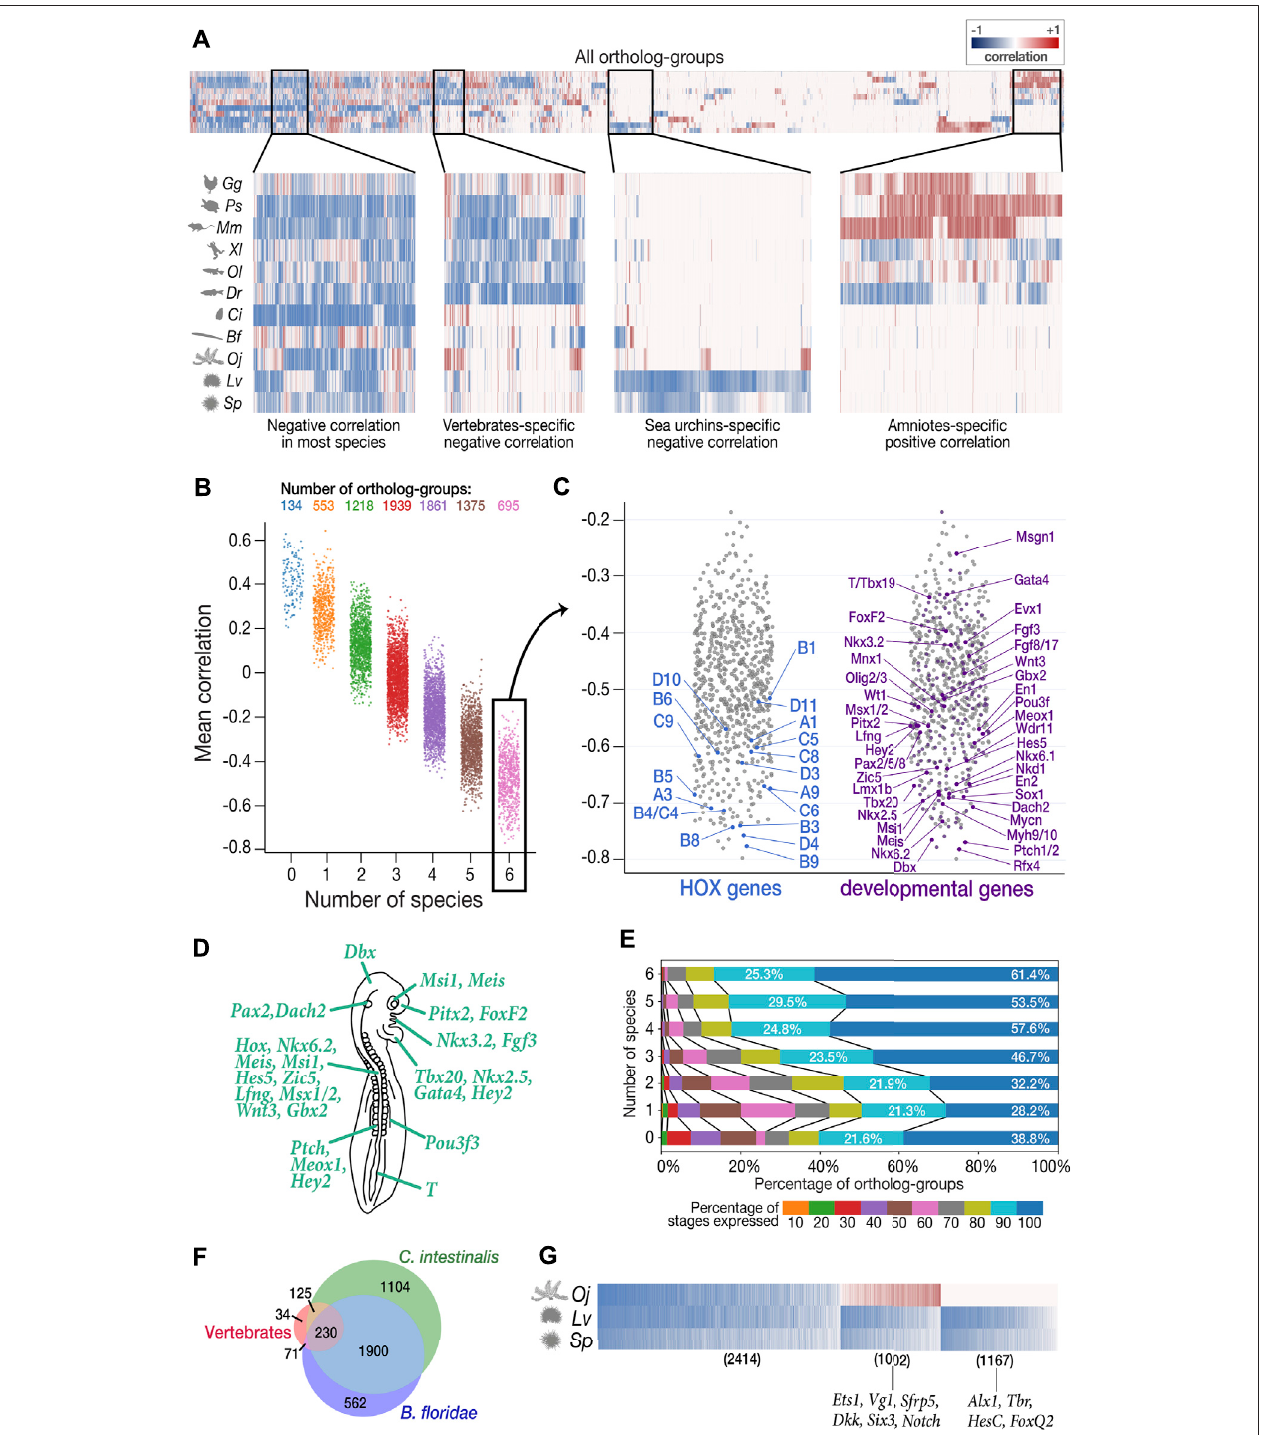
FIGURE 5 | Characterization of least derived stages by ortholog-groups. (A) Heatmap showing Spearman ’ s correlation coef fi cient between expression levels and derivednessindicesforeach ortholog-groupforeach species(blue:negativecorrelation;red:positivecorrelation).Selectedareas intheheatmaparezoomed intoshow clusters of ortholog-groups with (from left to right) negative correlation in most species; negative correlation in most vertebrate species; negative correlation only in the two sea urchins; positive correlation in amniotes (mouse, chicken, and turtle). (B) Ortholog-groups showing negative correlation (negative DCOs) in vertebrates. 7,775 ortholog-groups were analyzed for vertebrates, and were further classi fi ed into seven categories based on the number of species in which they show negative correlation. 695 ortholog-groups in category 6 (showing negative correlations in all six vertebrate species analyzed) were further analyzed in (C – E) . (C) Category 6